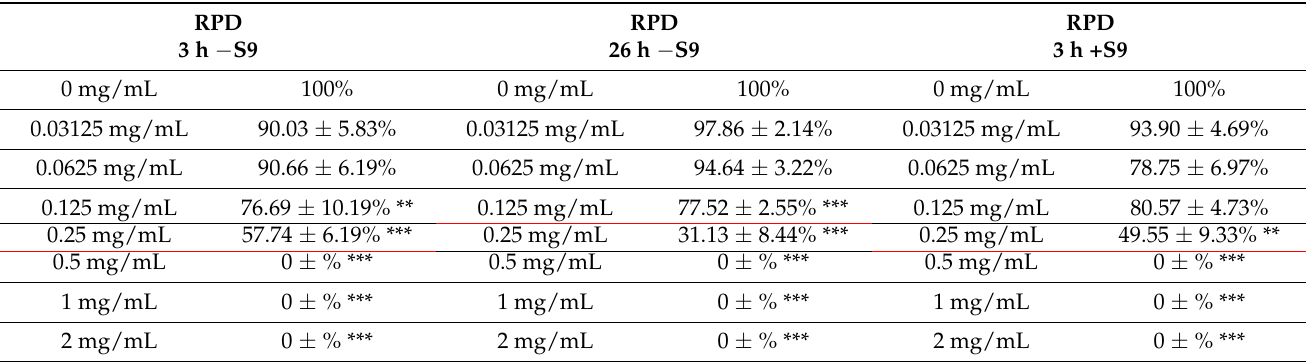
Table 3. RPD on TK6 cells after 3 h − S9 mix, 26 h − S9 mix and 3 h +S9 mix treatment with the SMD at the indicated concentrations compared to the concurrent negative control (0 mg/mL). Each value represents the mean ± SEM of at least three independent experiments. Data were analysed using repeated ANOVA, followed by Dunnet post-tests. ** p < 0.01 vs. [0 mg/mL]; *** p < 0.001 vs. (0 mg/mL). The red lines highlight up to which concentration the OECD threshold for cellular replication is